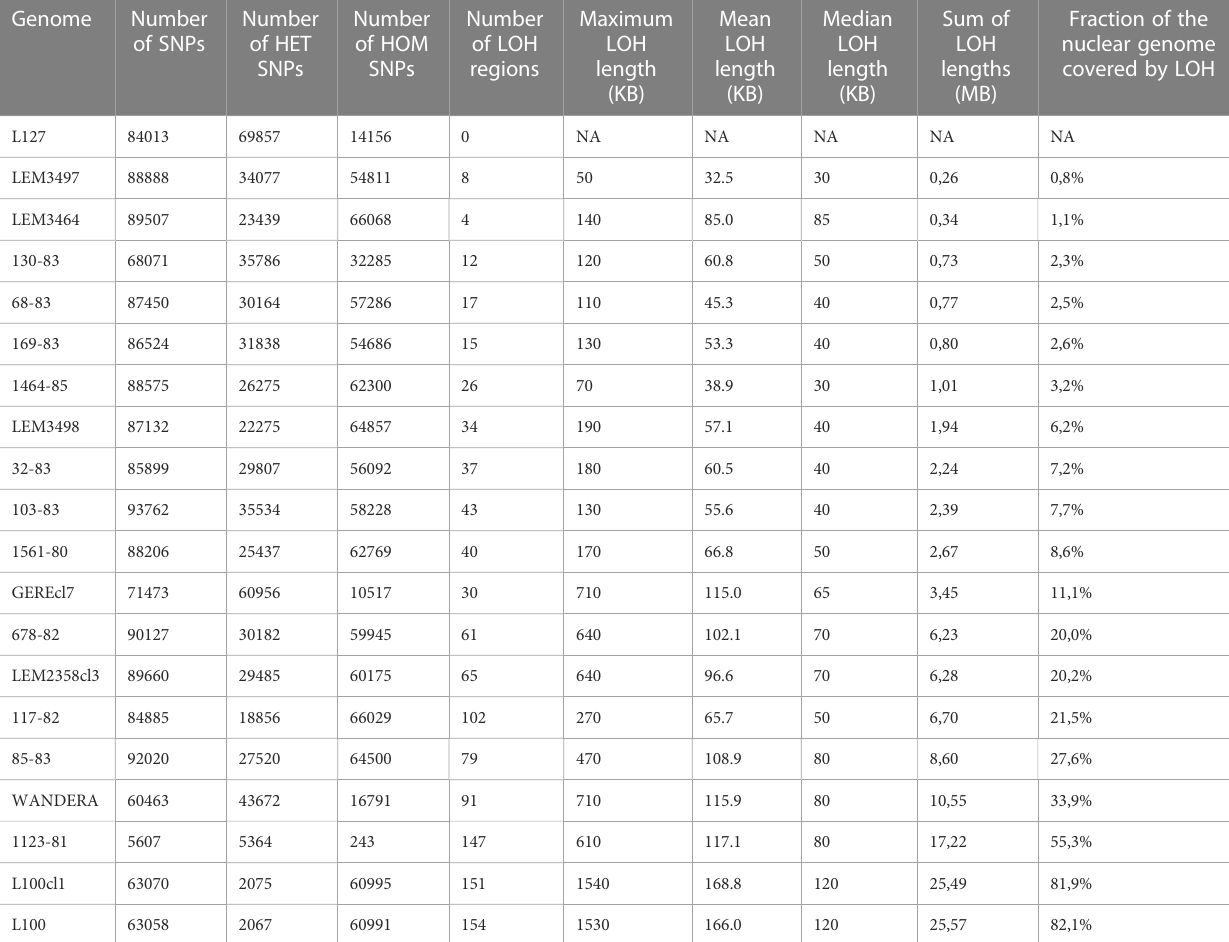
TABLE 1 Population genomic statistics for each of the 20 L. aethiopica